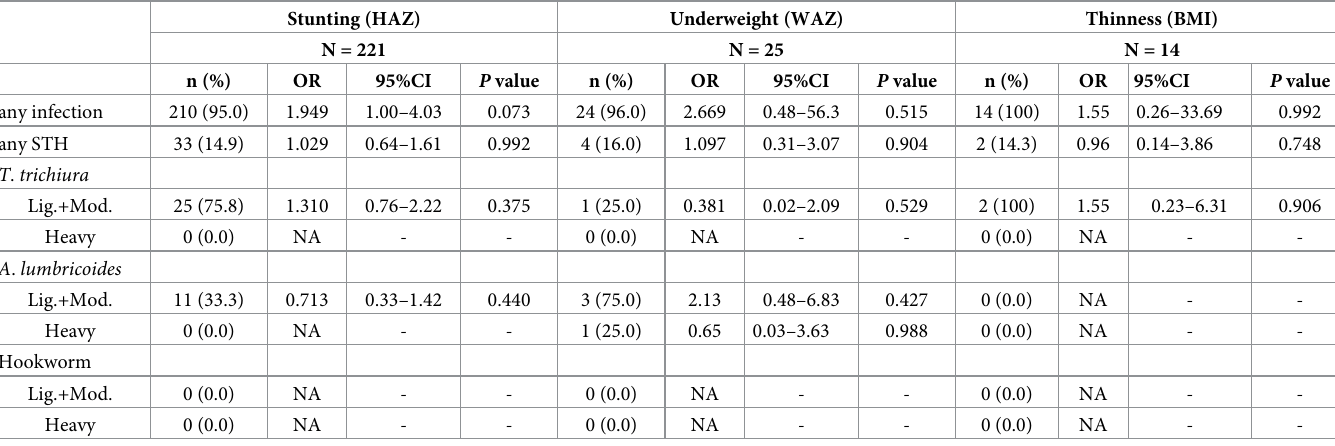
Table 6. Odds ratios for nutritional status in infected school children. Stunting